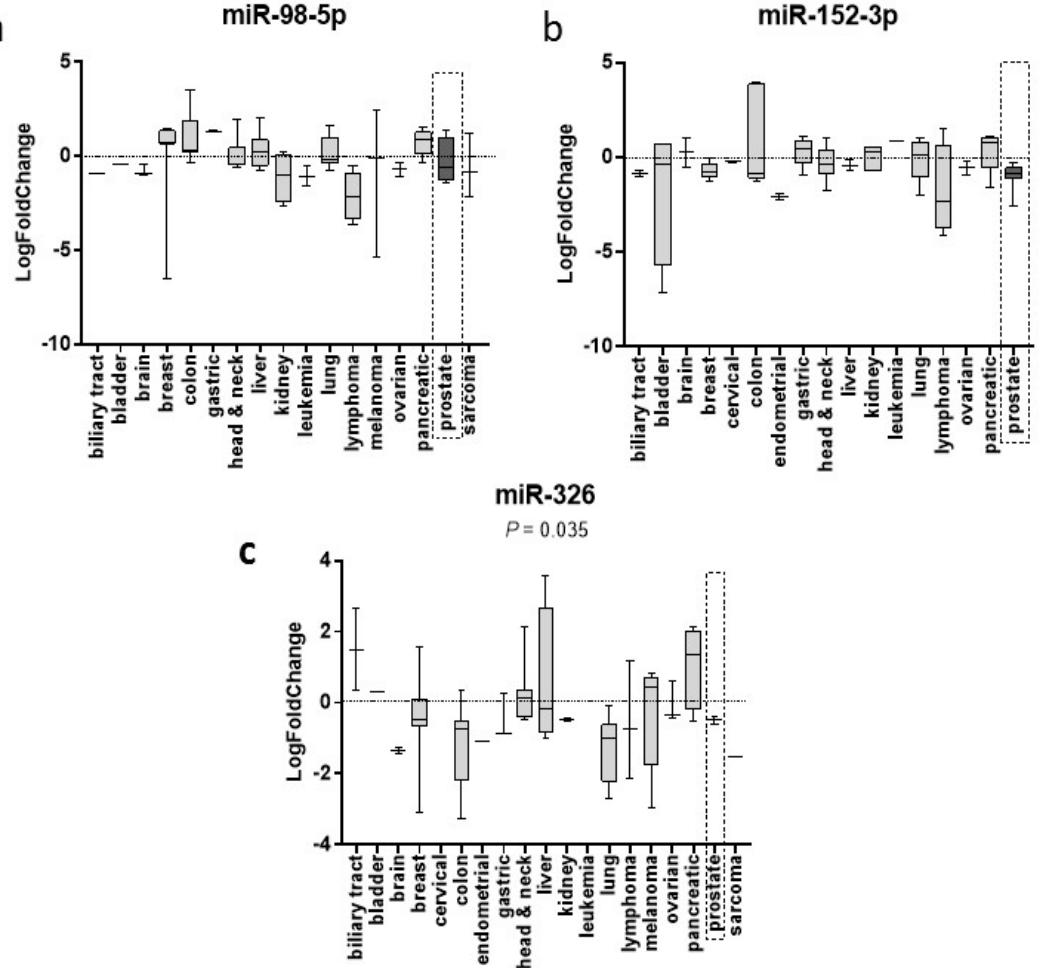
Figure 1. Differential expression of miR-98-5p, miR-152-3p and miR-326 in cancer tissue. Data sourced from dbDEMC [66]. Logarithmic fold changed plotted (GraphPad Prism 7.00) showing min to max values and median. Dark grey shade and dashed rectangular highlight PCa only. P values obtained from one-way analysis of variance